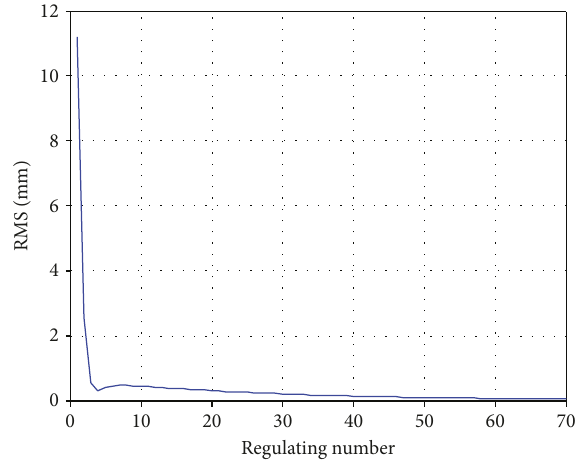
Figure 6: Root mean square (RMS) based on 25 Adaptive algorithm parameters of the fuzzy observers